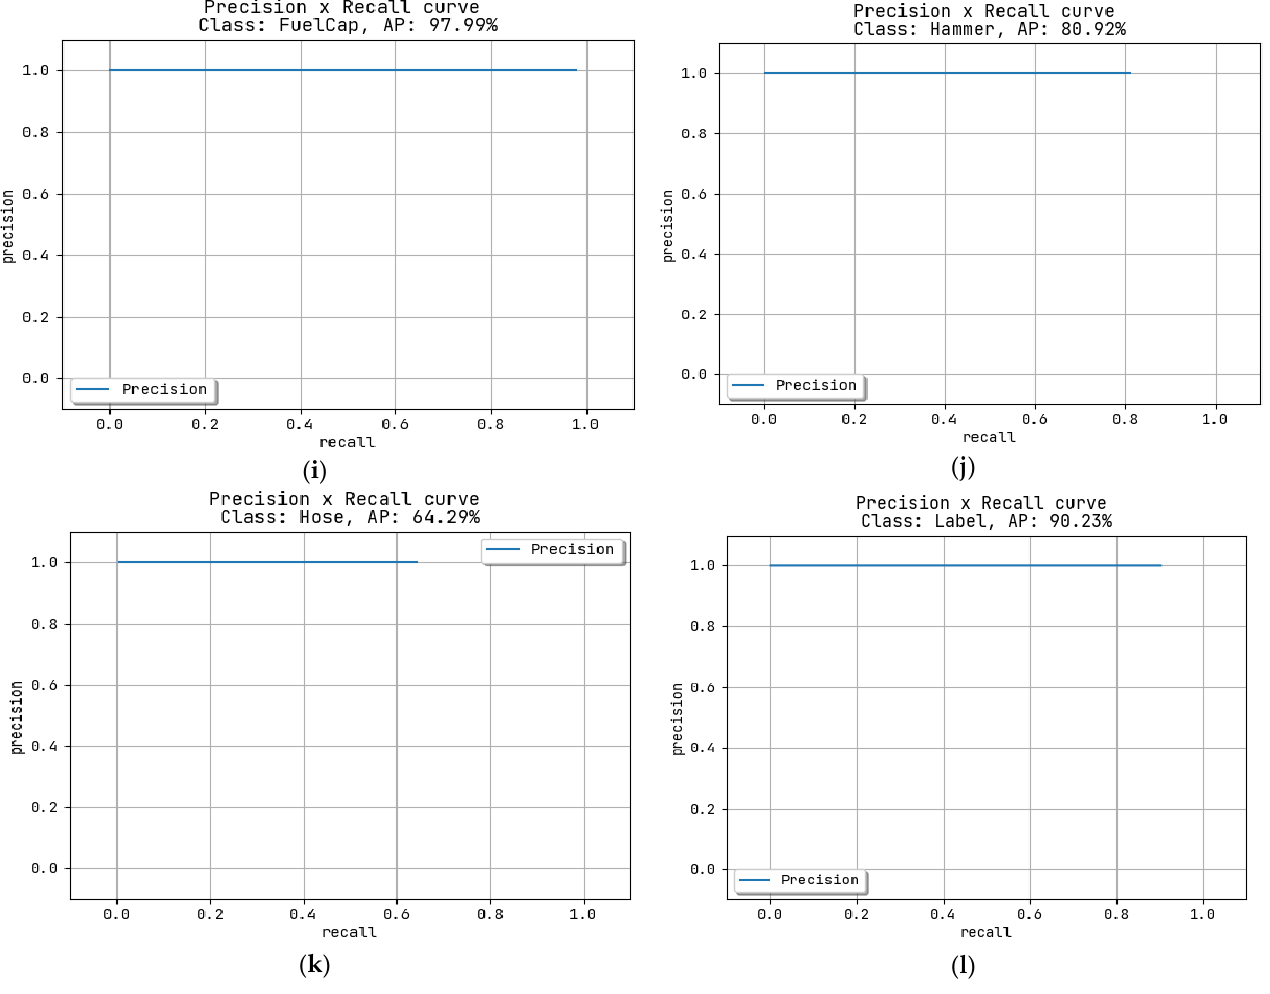
Figure 5. Analysis of precision (vs.) recall for various classes ( a ) AdjustableClump ( b ) Adjustable Wrench ( c ) Battery ( d ) Bolt ( e ) BoltNutSet ( f ) BoltWasher ( g ) Clamppart ( h ) Cutter ( i ) FuelCamp ( j ) Hammer ( k ) Hose ( l ) Labe.